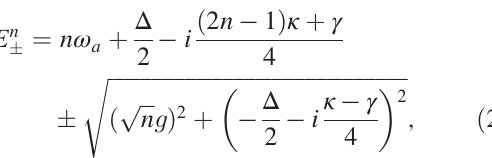
FIG. 1. (a) Schematic illustration of the energy structure of a strongly coupled system as given by the Jaynes-Cummings ladder obtained from Eq. (2). The blue arrow illustrates resonant excitation of UP1, the red arrows show photon decay, and the purple arrow is the phonon-assisted transfer. (b) Cross-polarized reflectivity spectra of the coupled QD-cavity system obtained by temperature tuning the QD through the cavity resonance. An anticrossing of the peaks clearly demonstrates the strong coherent